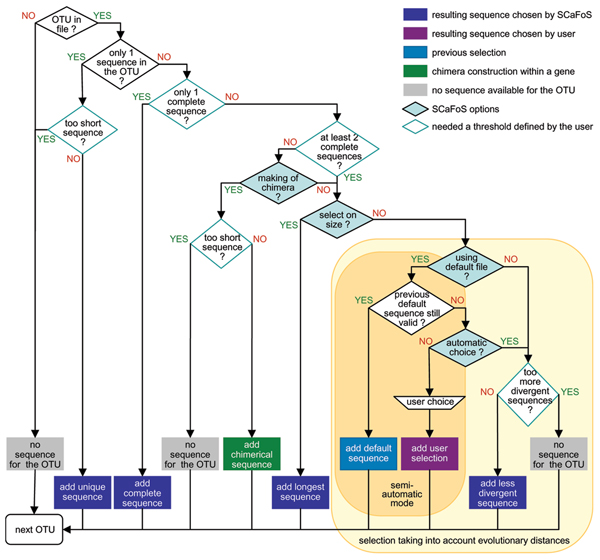
Flowchart of sequences selection and construction of chimera for an OTU in a given gene. For each OTU of each gene, SCaFoS selects the sequence that best represents the OTU. See text for a detailed description of the process. Three thresholds (empty blue rhombus) with default or user specific values are important: (i) the maximal percentage of characters present with respect to the longest sequence to keep a sequence, (ii) the minimal percentage of characters present with respect to the longest sequence to consider a sequence as complete and (iii) the maximum in-OTU/out-OTU distances ratio (see text) to keep an OTU. The user should select if he/she desires to create or not chimerical sequences and chose among the different sequence selection criteria (filled blue rhombus). If the selection criterion is the sequence size, no other options should be checked. If the selection criterion is the evolutionary rate of the sequences, the user must chose between a fully automatic or a semi-automatic choice of sequences and specify if he/she desires to use a previously defined selection.